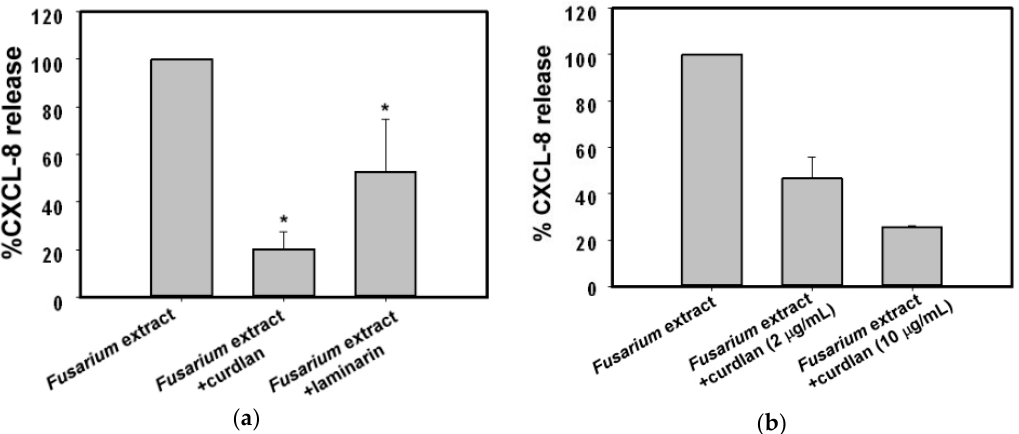
Figure 3. Effect of β -glucan on CXCL-8 release. ( a ) Curdlan (10 µg/mL) or laminarin (10 µg/mL) was added to BEAS-2B cells for 1 h prior to stimulation with 100 µg/mL of F. proliferatum extracts for 24 h. The supernatant was collected and the secretion of CXCL-8 determined by ELISA; ( b ) BEAS-2B cells were pre-incubated with curdlan at the indicated concentrations for 1 h. Cells were then exposed to F. proliferatum extracts for 24 h and the amounts of CXCL-8 in the cultured supernatants were determined by ELISA. The results are representative of three ( a ) and two ( b ) independent experiments performed in duplicate. Asterisks (*) indicate significant differences ( p < 0.05) between the paired samples.